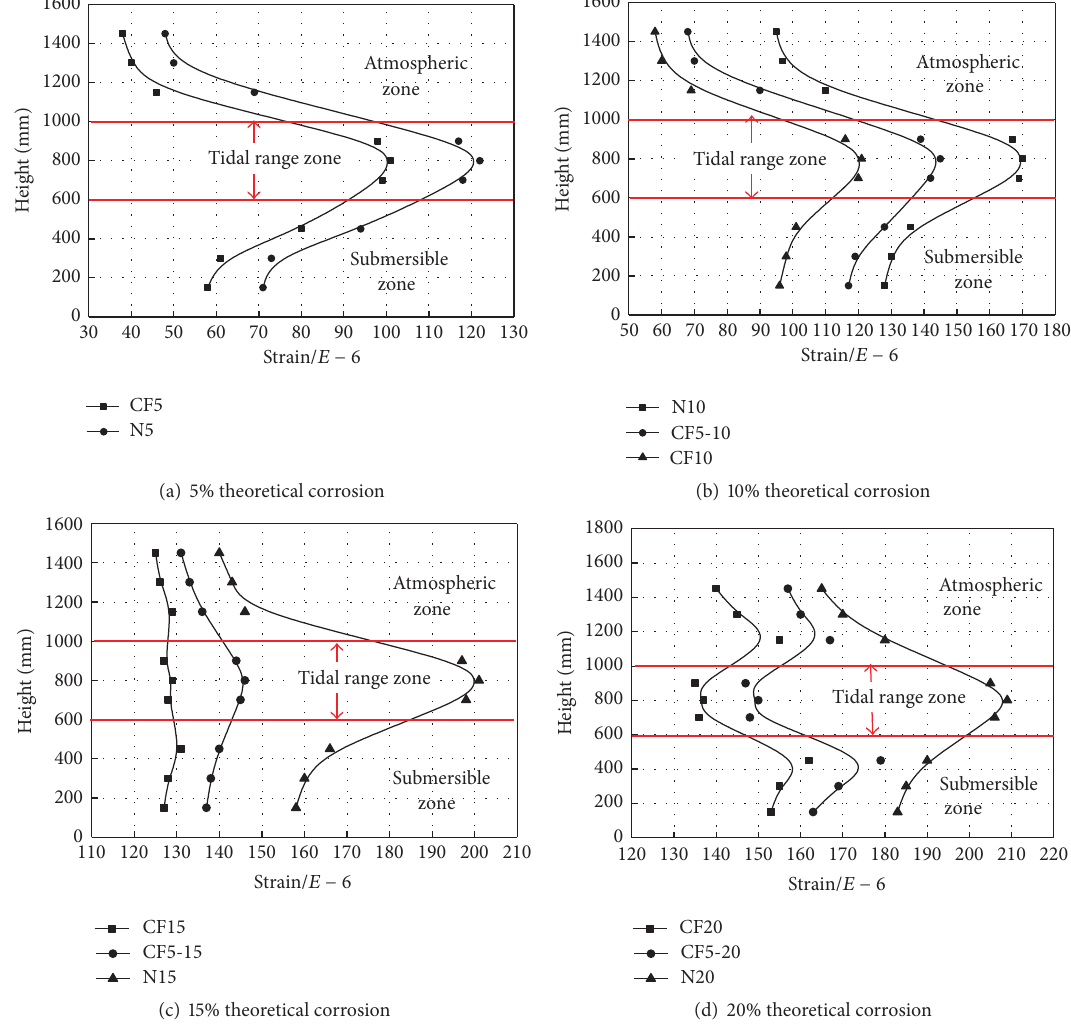
Figure 9: Strains of piles at different corrosion